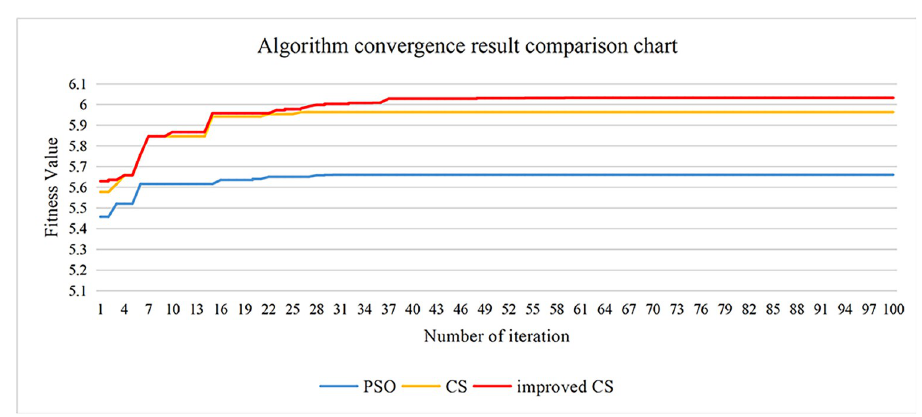
Fig 5. Convergence rate analysis for platform limit parameter optimization using PSO, CS and improved CS.